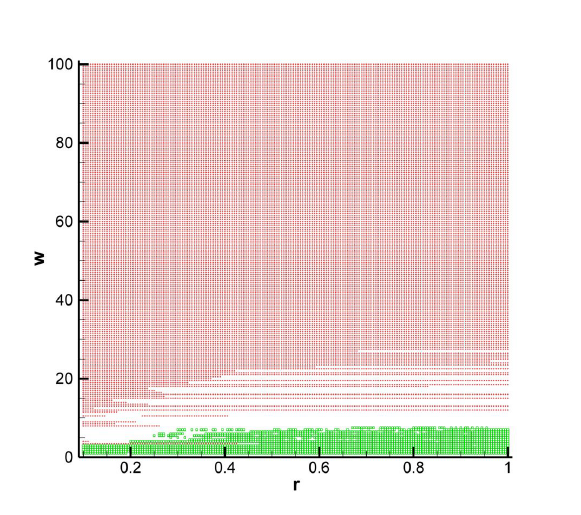
Figure 3: Region diagram with varying system parameters r and ω ( k =0.5)